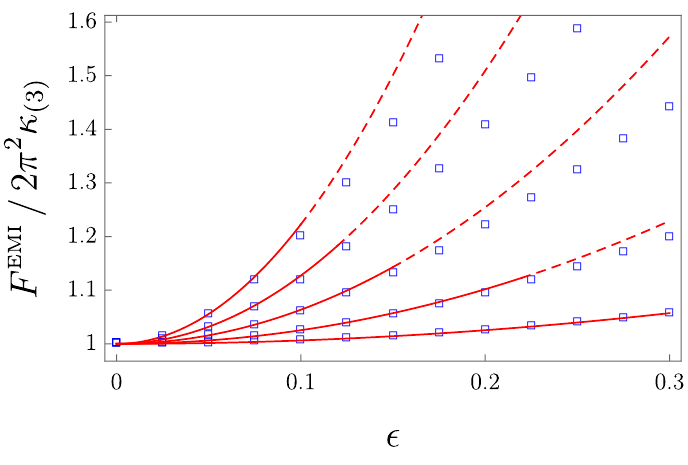
Figure 5 . We plot the universal piece F EMI for small deformations of a disk region corresponding to (4.20) for ‘ = 2 , 3 , 4 , 5 , 6 as a function of the small parameter (cid:15) . The blue dots are obtained numerically integrating (4.4) in each case. The red lines correspond to the leading-order parabolic approximations produced by Mezei’s formula